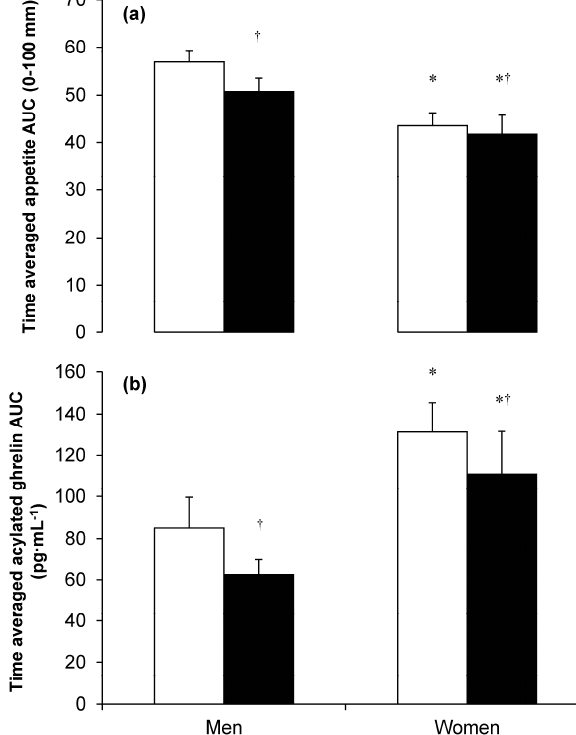
Figure 1. Time averaged total area under the curve (AUC) for appetite ratings ( a ); and plasma acylated ghrelin concentrations ( b ) in the control ( (cid:3) ) and exercise ( (cid:4) ) conditions. Each condition was 7 h and a single bout of exercise was performed between 0 to 1 h in the exercise condition (60 min running at 70% peak oxygen uptake). † Significant difference between exercise and control p ≤ 0.05; * Significant difference between women and men p ≤ 0.05. Values are mean (SEM), appetite ratings: n = 10 men, n = 10 women; acylated ghrelin: n = 8 men, n = 8 women. Data reproduced from reference [15]. © Wolters Kluwer Health, Inc. Reproduced with